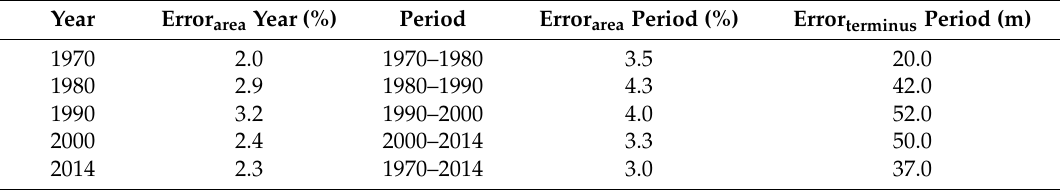
Table 3. Error estimates for area (year), area change (period) and glacier terminus change (period).